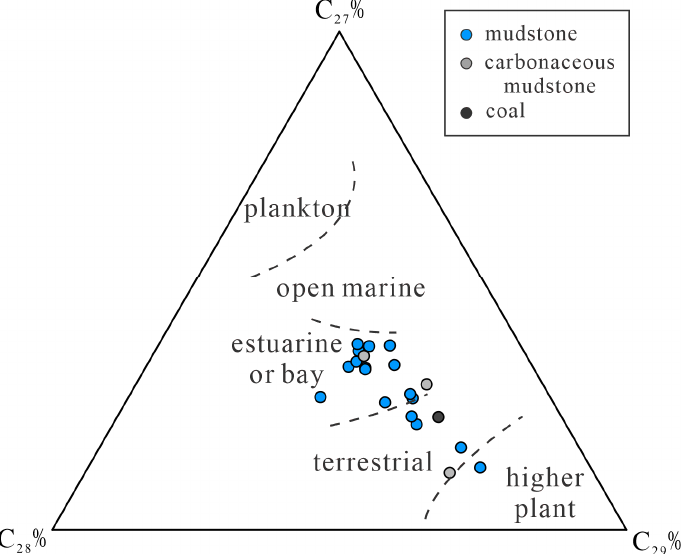
Figure 7. Ternary plot of regular steranes, showing the normalized abundance of C 27 , C 28 and C 29 sterane isomers and their depositional facies (after Huang and Meinschein, 1979 [37]). Dibenzothiophene (DBT) and phenanthrene (P) in aromatic hydrocarbon parameters can indicate the depositional environment. The DBT/P ratio combined with the Pr/Ph ratio can divide the depositional environment and lithology of source rock samples, which is an effective parameter to distinguish marine and continental source rocks. Hughes et